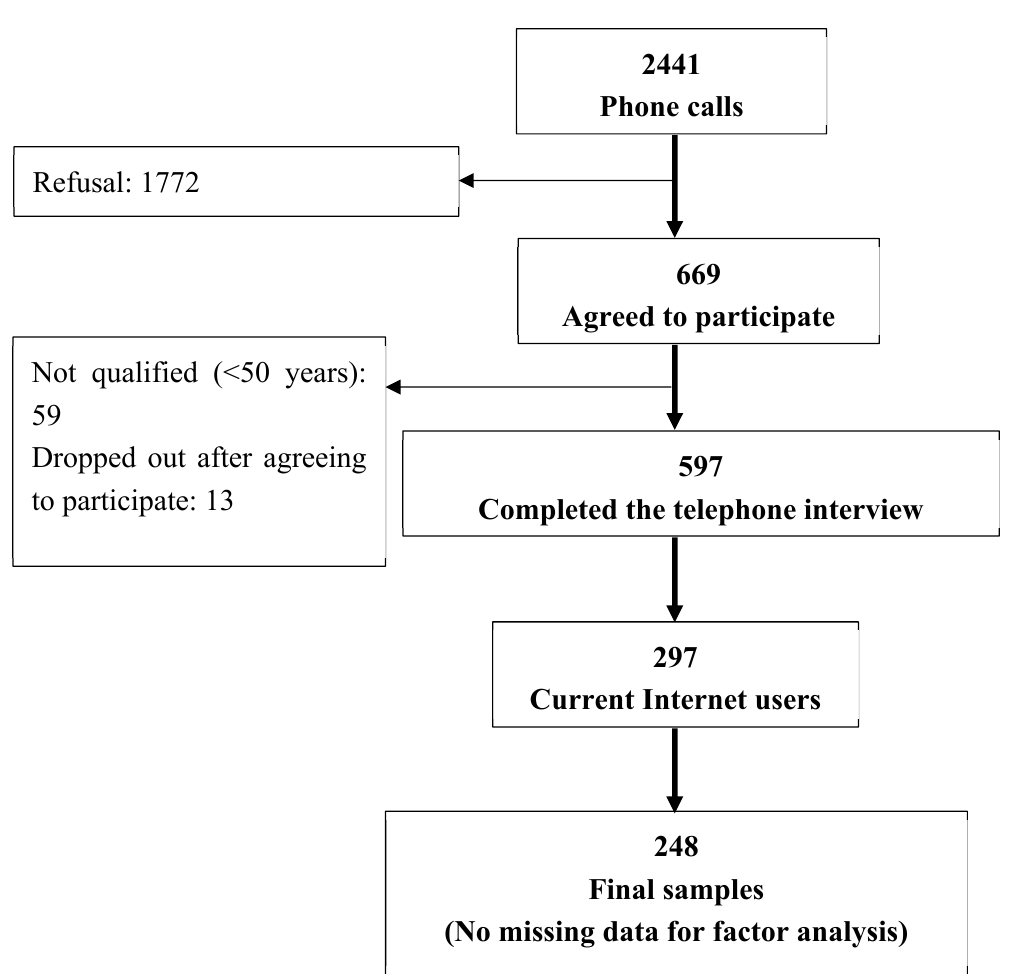
Figure 1. Flow diagram of the telephone interview and final analysis sample.